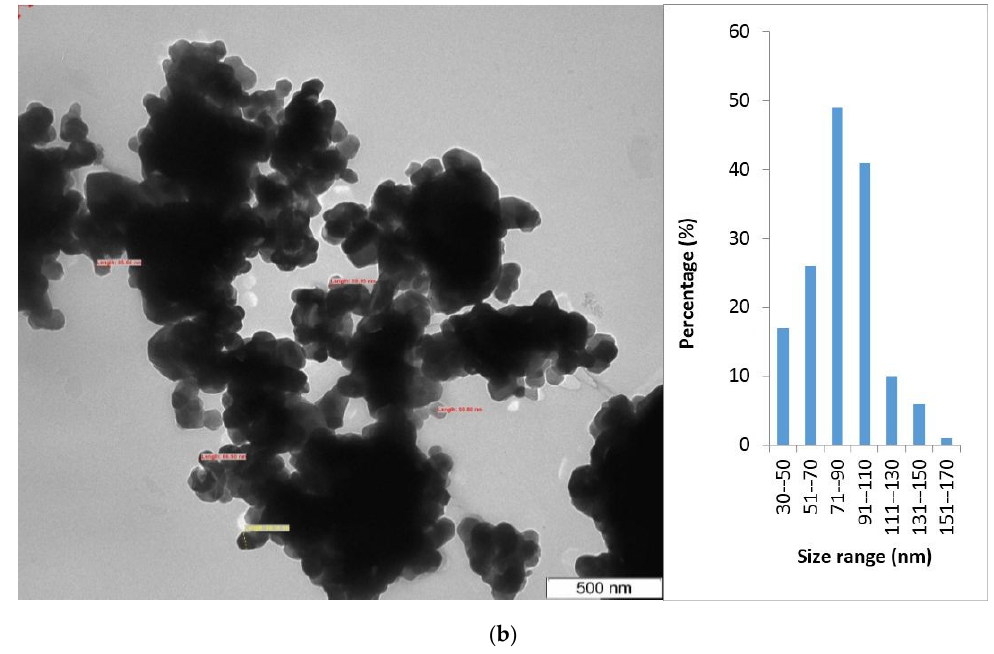
Figure 3. ( a ) Transmission electron microscope (TEM) image of calcined copper ferrite powder and the corresponding particle size histogram; ( b ) TEM image of calcined zinc ferrite powder and the corresponding particle size histogram.